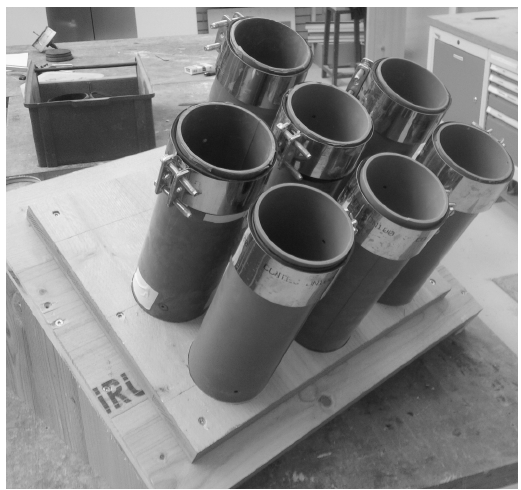
Figure 1. Molds for sprayed specimens: slotted tubes, fixed with a clamp on the upper side and mounted on a wooden